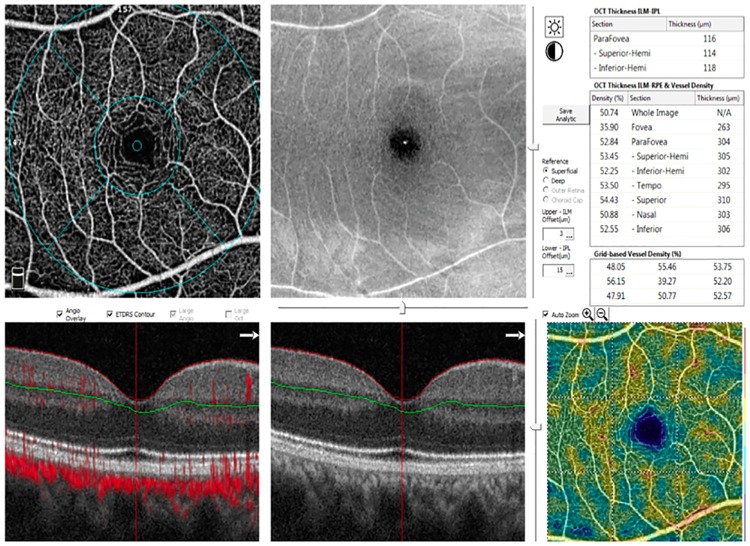
Representative OCTA vessel density report of myopic eye.Figure panel shows: the image of the macular vessels, separately calculated in five regions (fovea, temporal, superior, nasal and inferior) based on the ETDRS contour, OCT en face image, B-scans, and outcomes of quantitative analysis by the software.